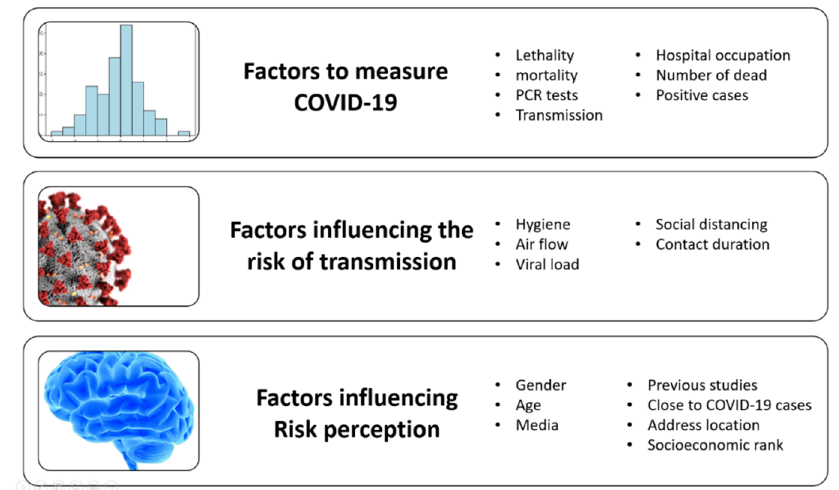
Figure 1. Concepts associated with COVID-19.